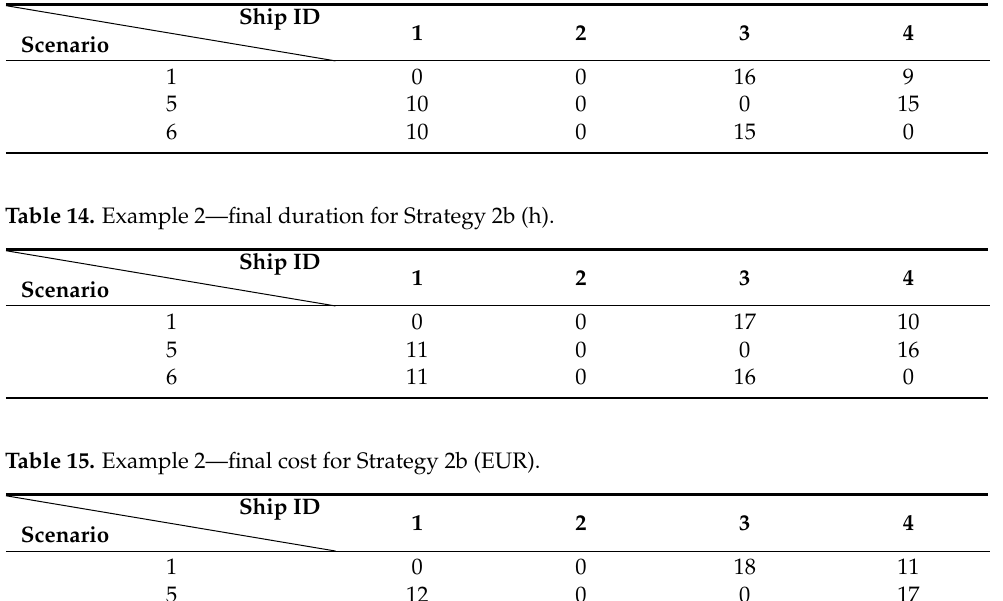
Table 13. Example 2—final allocation for Strategy 2b (m 3 ).